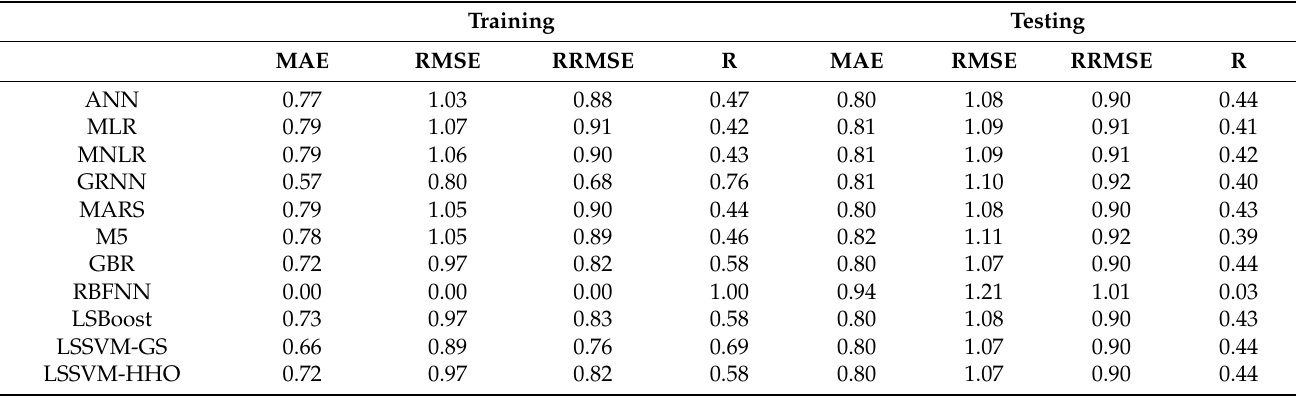
Table A7. Results of modeling WS with the base algorithms at the Ferdows